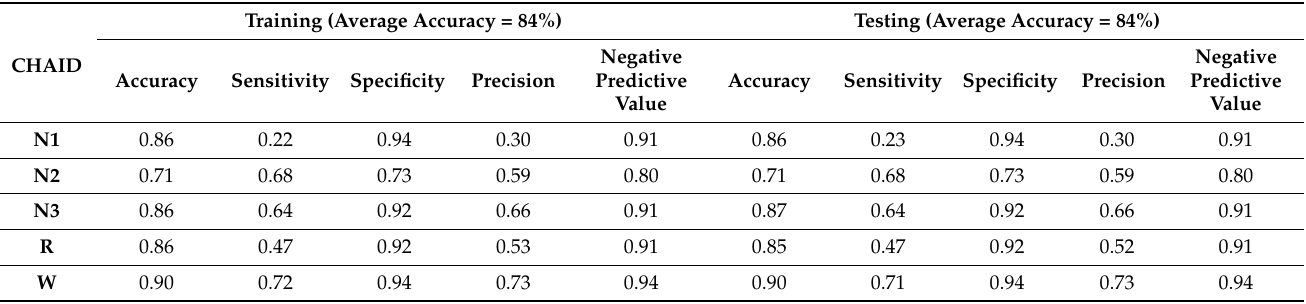
Table 9. Confusion matrix of the CHAID Model using training and testing datasets for the classifica- tion of EEG features of the sleep stages W, N1, N2, N-3, and